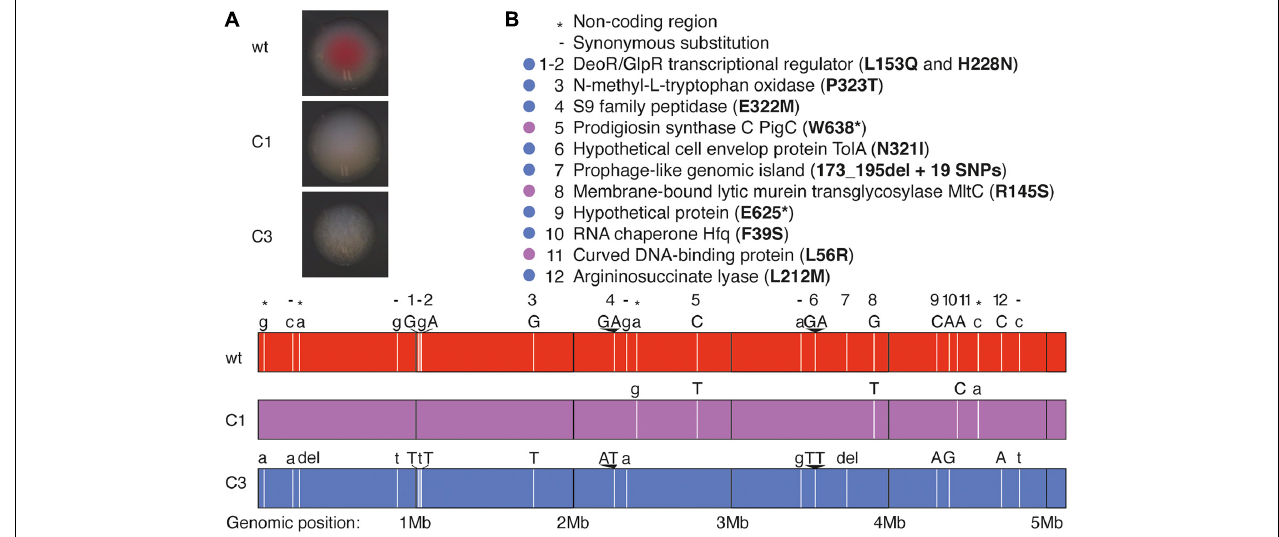
FIGURE 1 | Whole-genome sequencing analysis of S. marcescens VA prodigiosin-deficient mutants. (A) Pictures showing the aspect of colonies of wt S. marcescens VA and of its C1 and C3 mutants. (B) Description of the mutated loci in C1 and C3 mutants. Lower panel : Each vertical white bar represents the locus of a mutation, and the original (wt) and mutated (C1 or C3) nucleotides are indicated above the corresponding colored bars representing each genome. Uppercase letters indicate non-synonymous substitutions, while lower case letters and - indicate synonymous substitutions. The symbols * indicate mutations in non-coding regions. Upper panel : the legend indicates the gene where each mutation is located and the corresponding mutation in the amino acid chain. The color-code indicates the bacterial strains in which the mutations have been identified (purple: C1, blue: